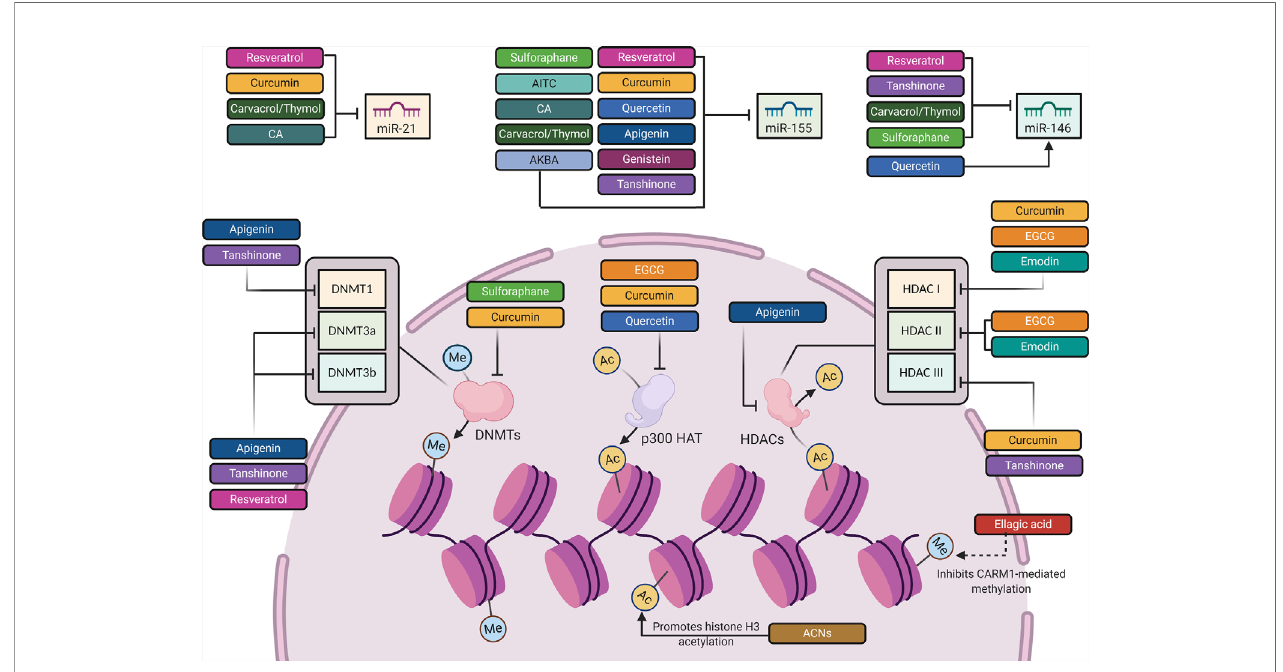
FIGURE 3 | The epigenetic mechanisms involved in the regulation of TLR4 signaling pathway by phytochemicals. Created with